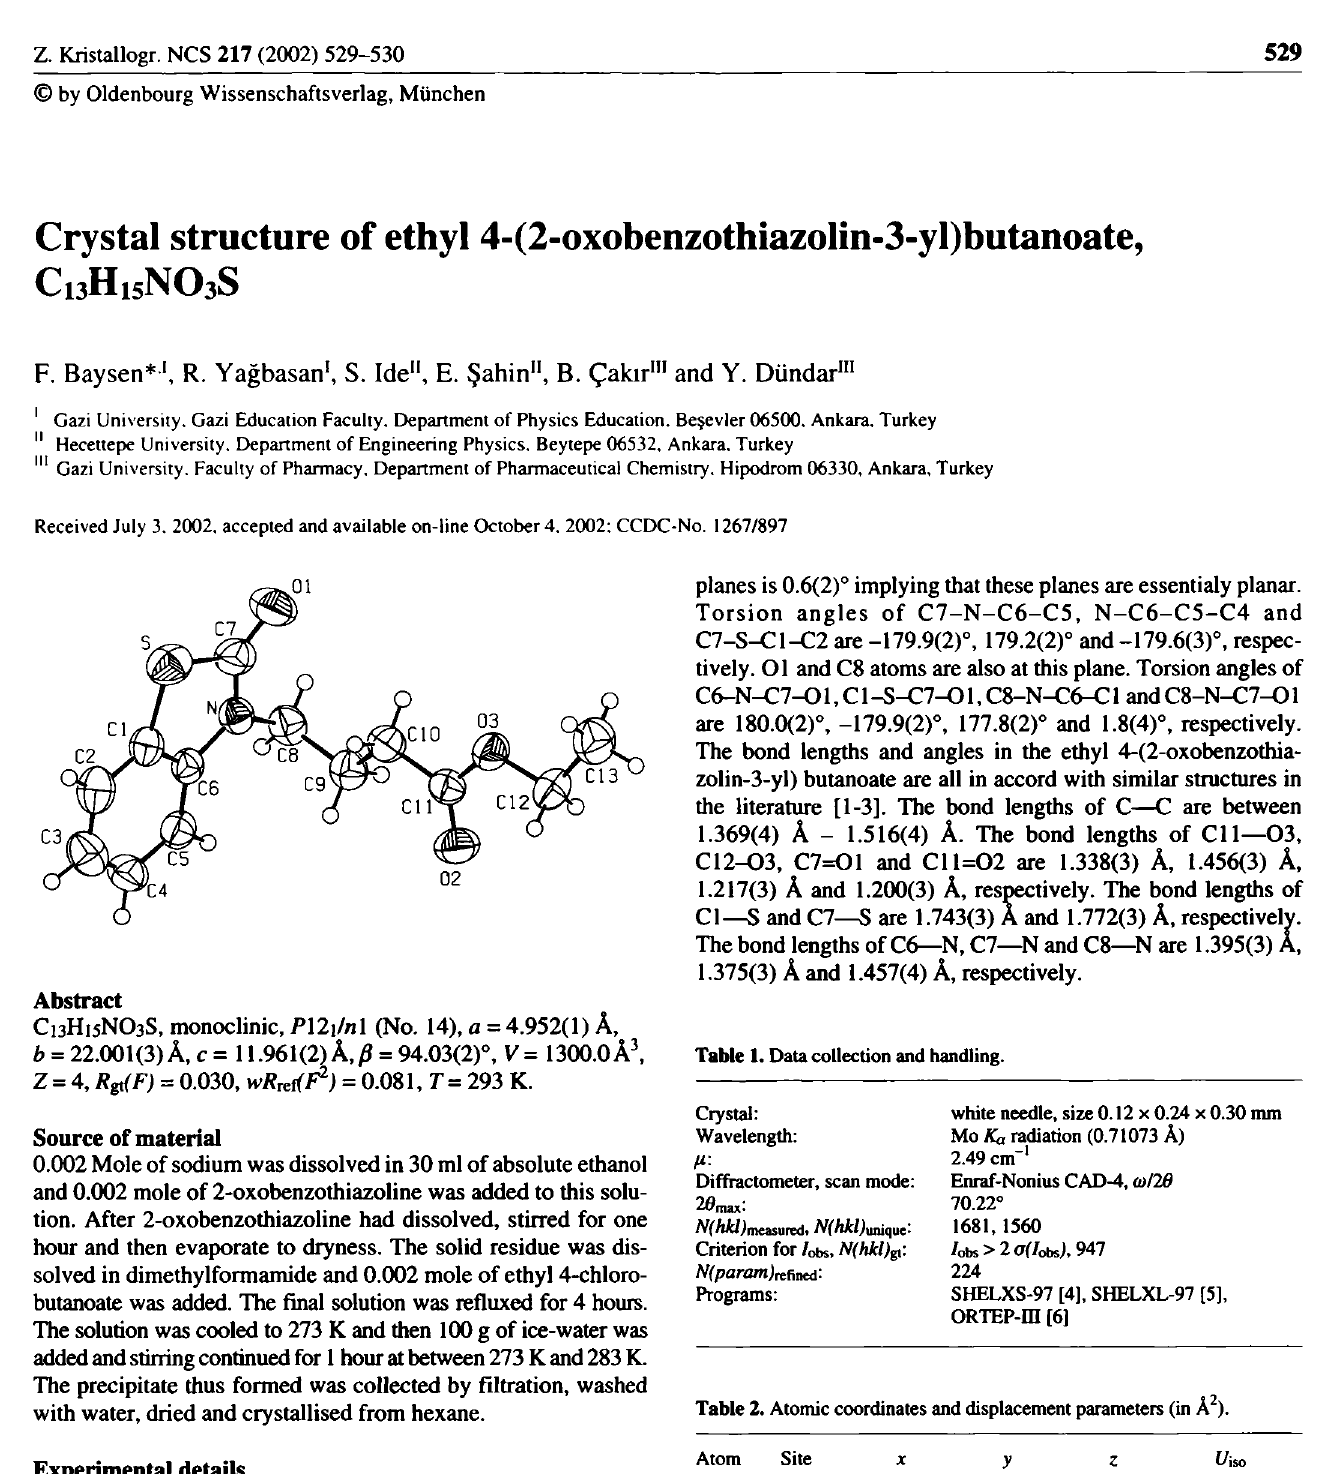
Table 2. Atomic coordinates and displacement parameters (in Â 2